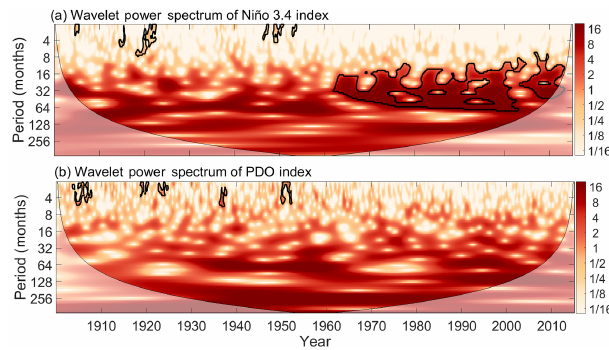
Figure 12. The application of the cumulative areawise test to the (a) Niño 3.4 index and (b) PDO index. Contours enclose regions of 1% cumulative areawise